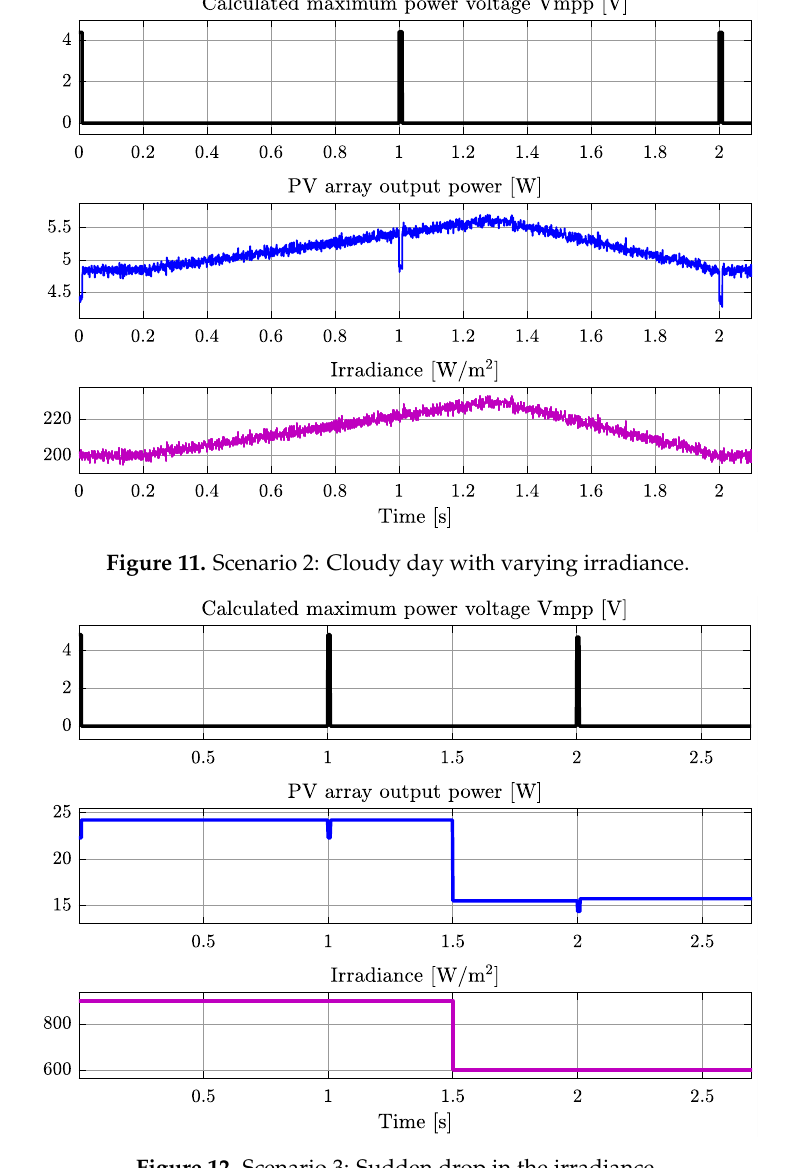
Figure 12. Scenario 3: Sudden drop in the